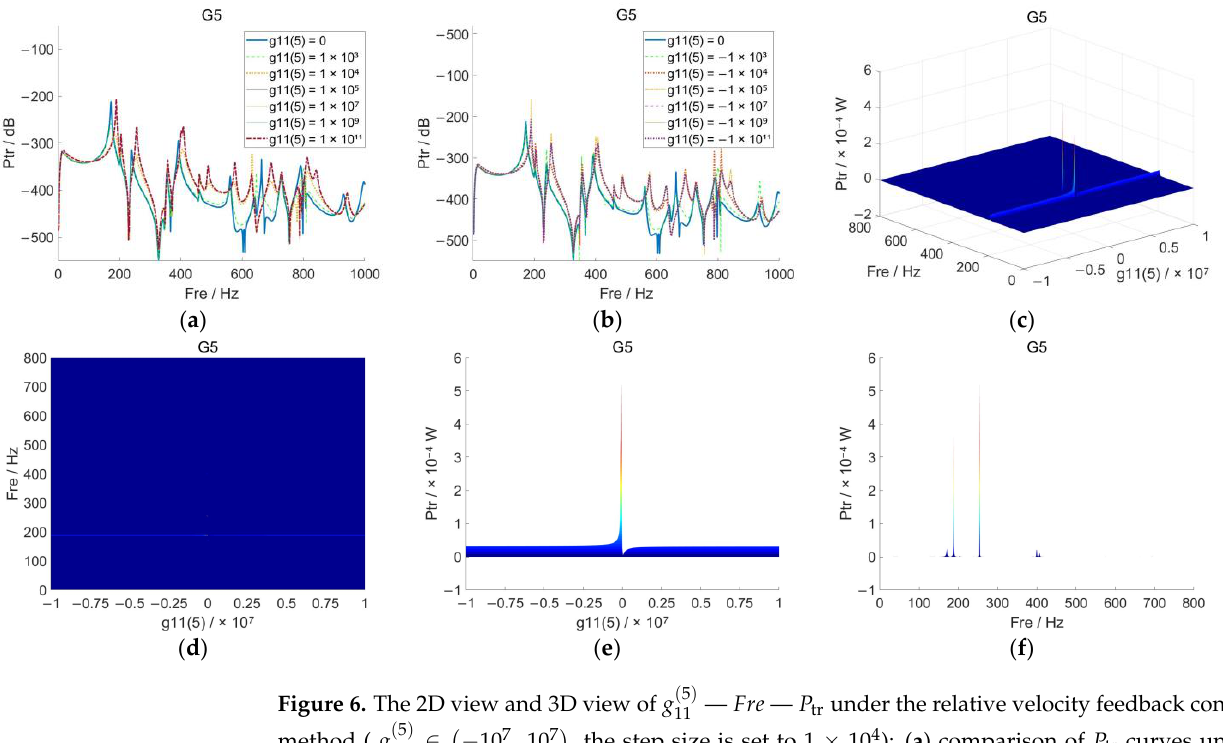
( 4 ) P under the relative displacement feedback g — Fre — Figure 5. The 2D view and 3D view of ( ) 4 Figure 5. The 2D view and 3D view of g — Fre — P tr under the relative displacement feedback 11 tr 11 ( 4 ) P curves under control method ( ( ) ( , the step size is set to 1 × 10 6 ): ( a ) comparison of ∈ (cid:0) − 10 9 , 10 9 (cid:1) , the step size is set to 1 × 10 6 ): ( a ) comparison of P tr curves control method ( g tr 11 ( 4 ) > 0; ( b ) comparison of P tr curves under g ( 4 ) < 0; ( c ) the 3D view of P tr curve under under g P curves under ( ) 4 P curve under continuous  ; ( b ) comparison of 0 g  ; ( c ) the 3D view of 11 11 11 tr tr ( 4 ) continuous variation of g ; ( d ) X-Y plane view; ( e ) X-Z plane view; ( f ) Y-Z plane view. g ; ( d ) X-Y plane view; ( e ) X-Z plane view; ( f ) Y-Z plane view. variation of ( ) 4 11 11